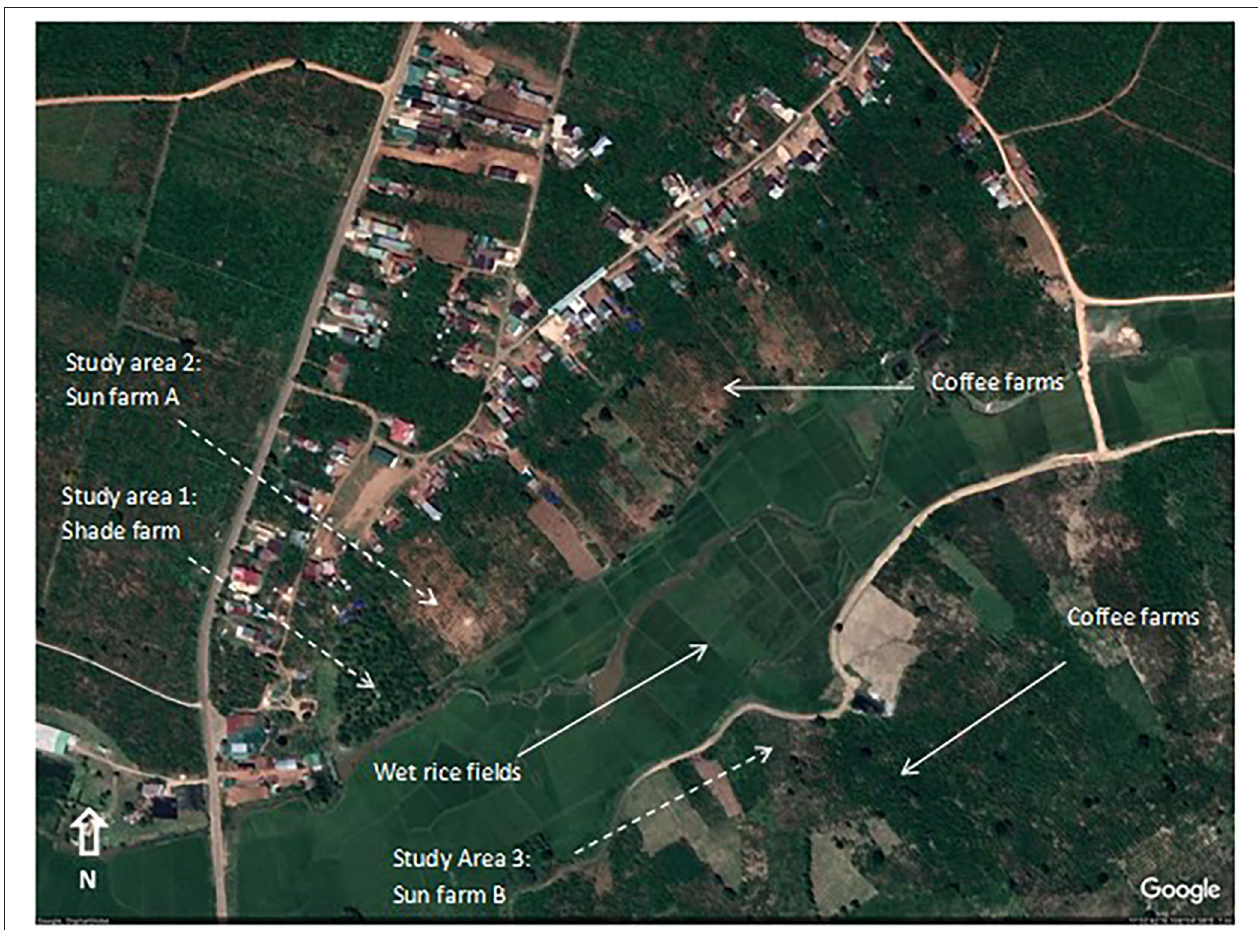
FIGURE 1 | L ˘ a ng Cú village, Gung Ré commune in Di Linh district of Lâm ` ông province. Source: Google Earth, Image @2019